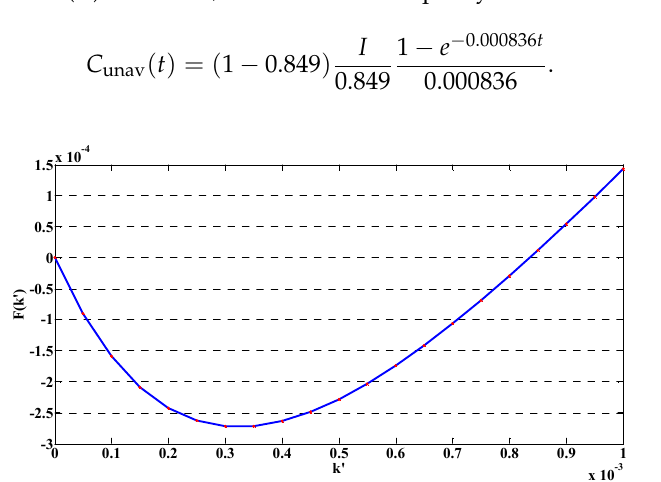
Figure 7. The function curve that changes as k’ changes.